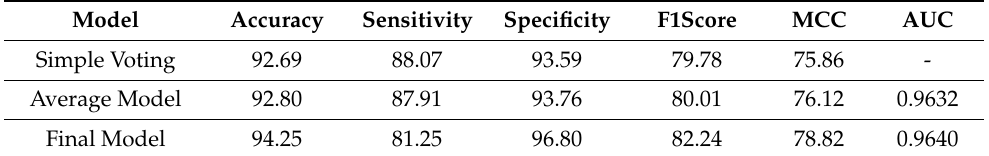
Figure 6. Confusion chart of the Visegrad group.